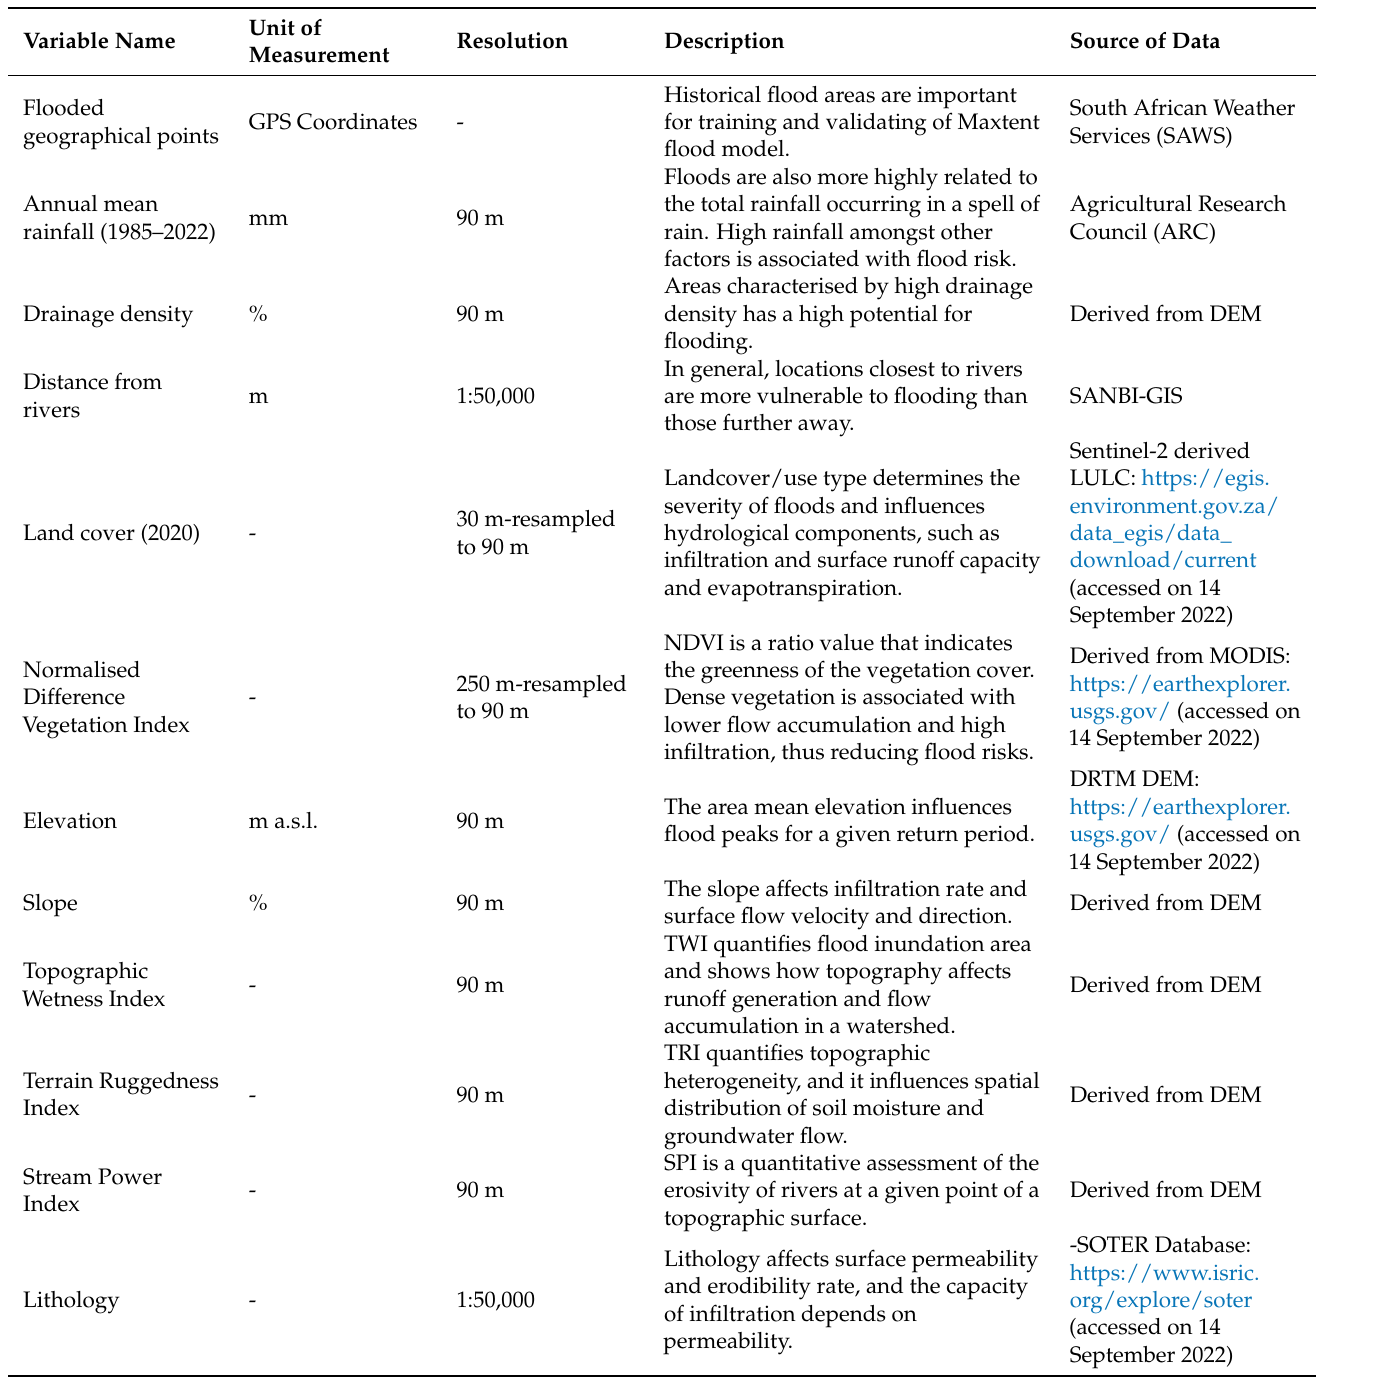
Table 1. Environmental variables used to build the MaxEnt